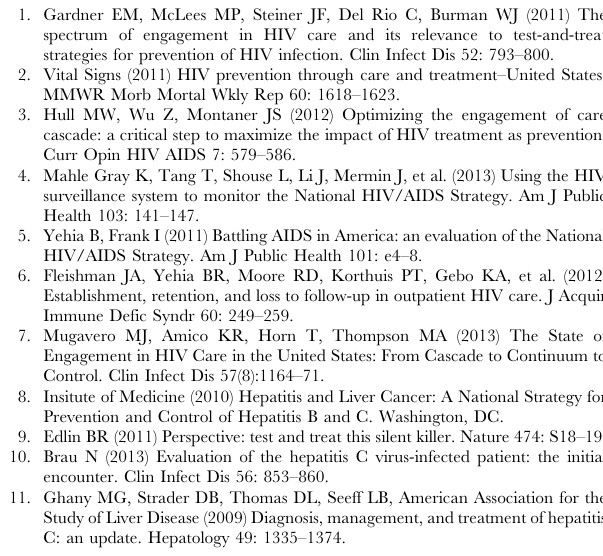
Table S1 Search strategy to identify studies addressing the 7 HCV treatment cascade